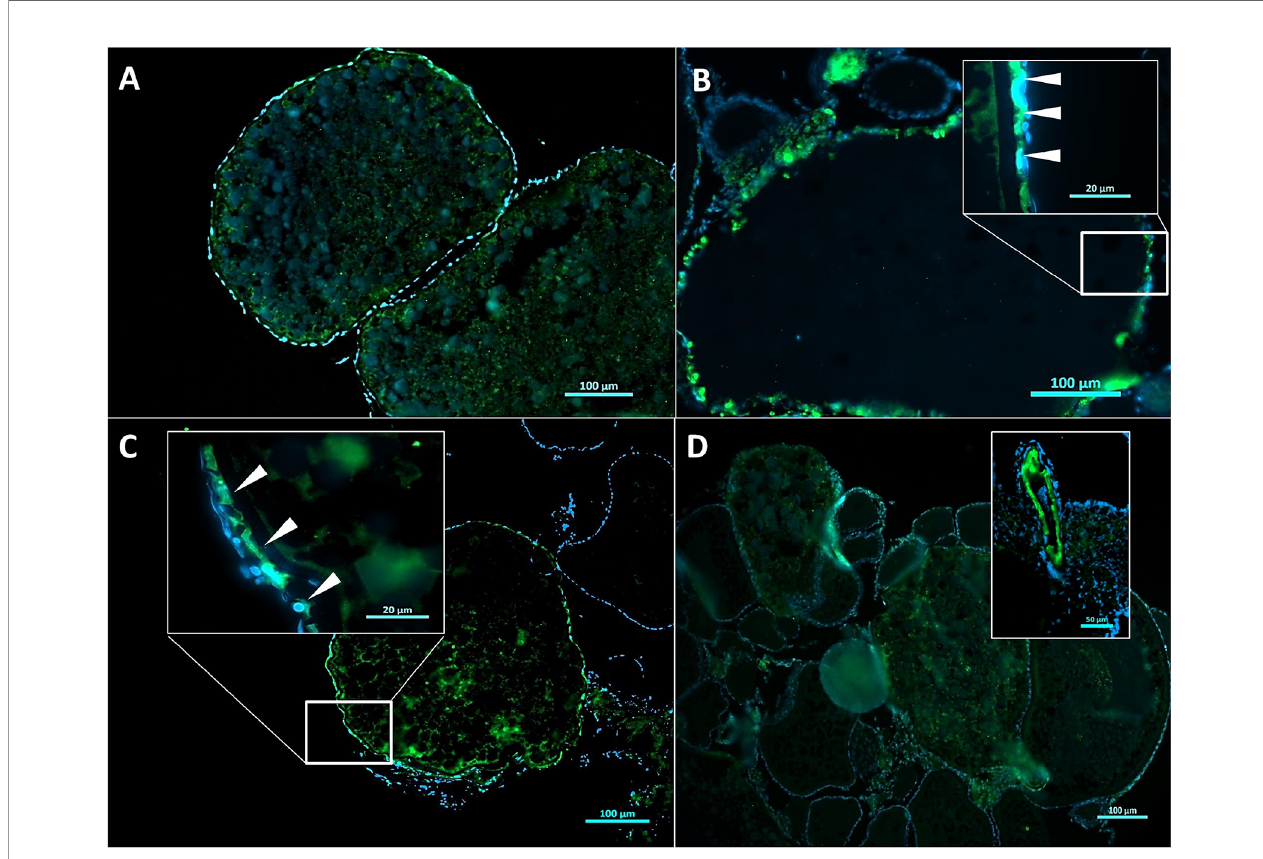
FIGURE 3 | Immunolocalization of CAS3 (ir-CAS3) in ovaries cross-sections from control and exposed zebra fi sh for 21 days to DiNP. CTL (A) , 0.42 m g L − 1 DiNP (B) , 4.2 m g L − 1 DiNP (C) , 42 m g L − 1 DiNP (D) . CAS3 signal in green (arrowheads) and DAPI nuclei counterstaining in blue. Scale bar: 100 m m; insert in (B, C) 20 m m; insert in (D) 50 m m.